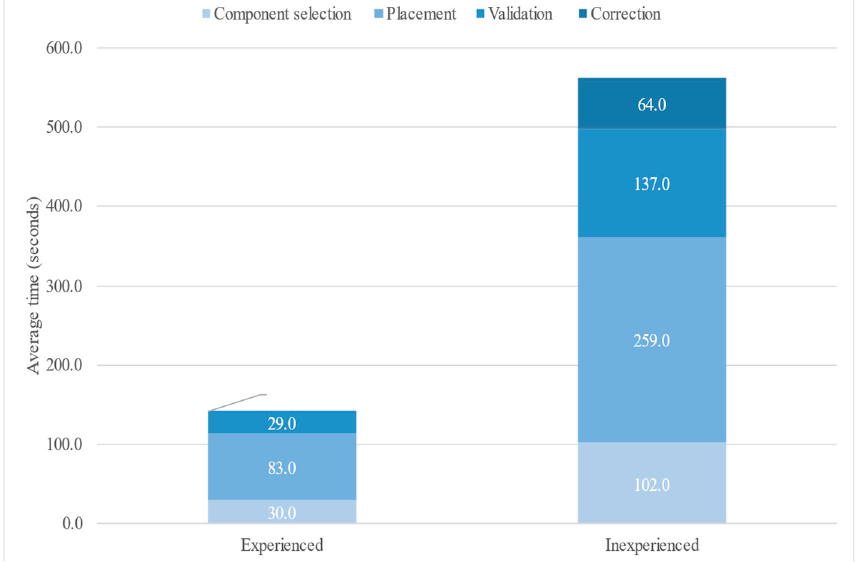
Figure 16. The average total time from experienced and inexperienced users when using the MR app.